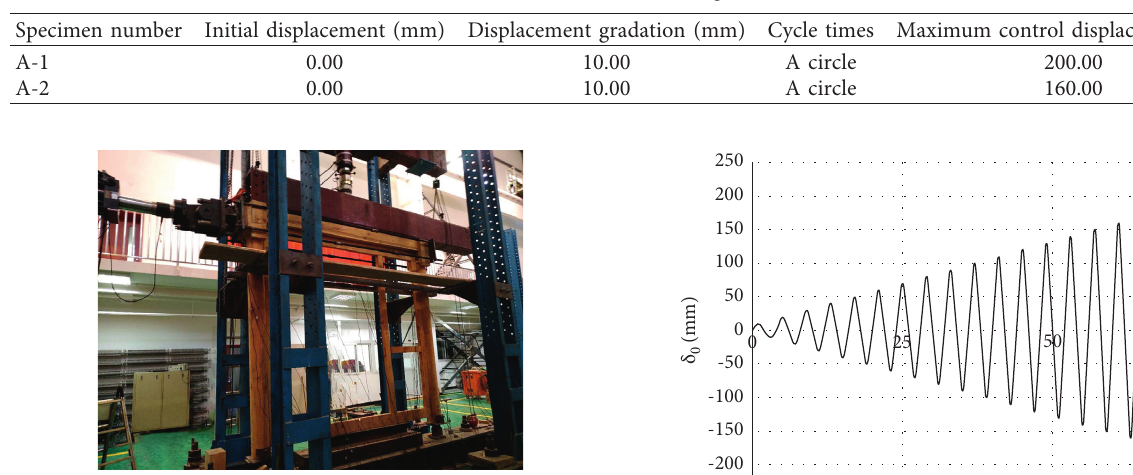
Table 3: Horizontal loading scheme.